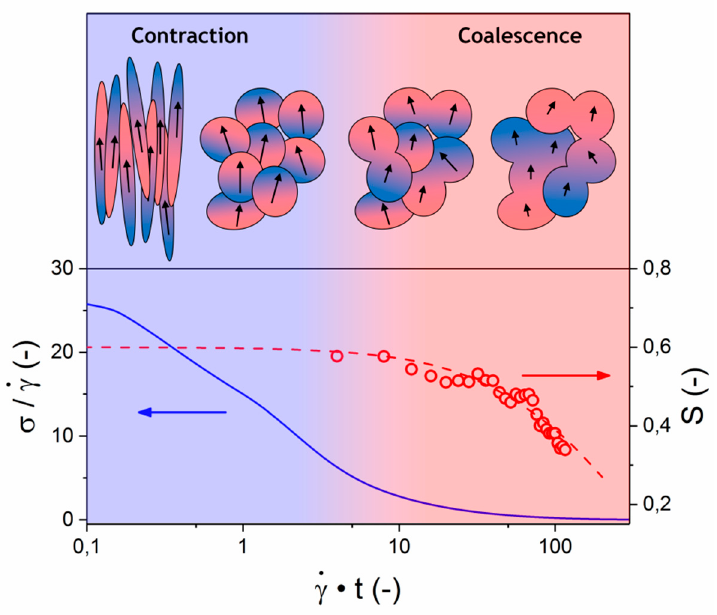
Figure 12. Overview of relaxation processes and timescales in LCP.